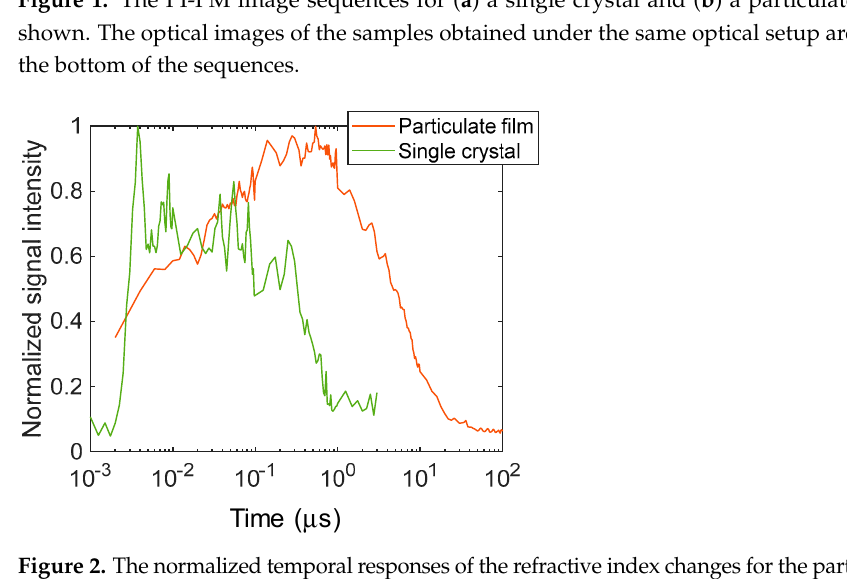
Figure 2. The normalized temporal responses of the refractive index changes for the particulate film and the single crystal of TiO 2 are shown. The signal amplitude was calculated from the images of Figure 1.